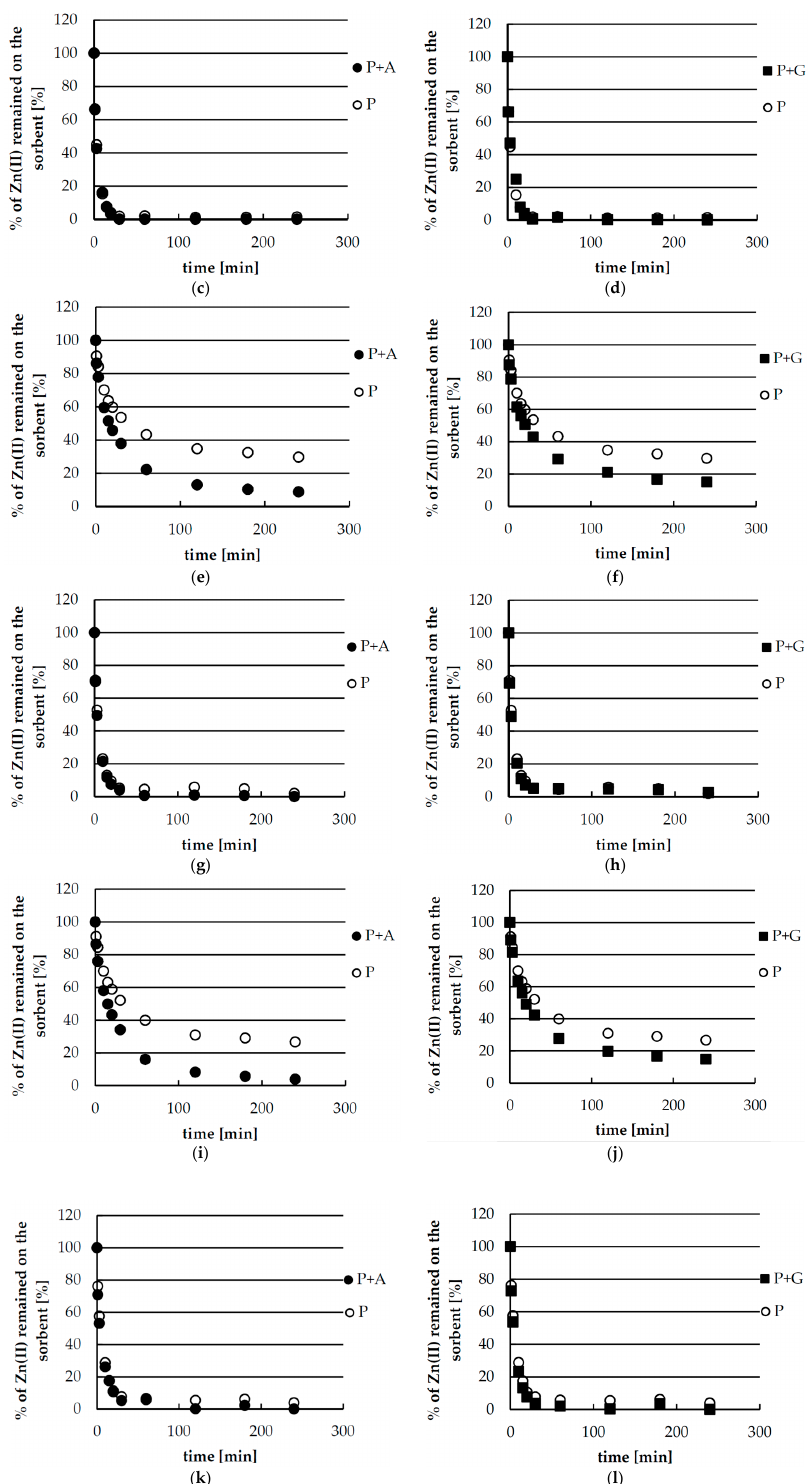
Figure 5. Kinetics of zinc(II) ions desorption from pectin-based biosorbents (P + A—hybrid pectin biosorbent with agar, P + G—hybrid pectin biosorbent with guar gum, P—sole pectin biosorbent) using various acid solutions of various concentration: ( a , b ) 0.01 M HNO 3 ; ( c , d ) 0.1 M HNO 3 ; ( e , f ) 0.01 M HCl; ( g , h ) 0.1 HCl; ( i , j ) 0.005 M H 2 SO 4 ; and ( k , l ) 0.05 M H 2 SO 4 . Mass of sorbent 0.75 g, volume of solution: 0.25 L, temperature 22 ± 1 ◦